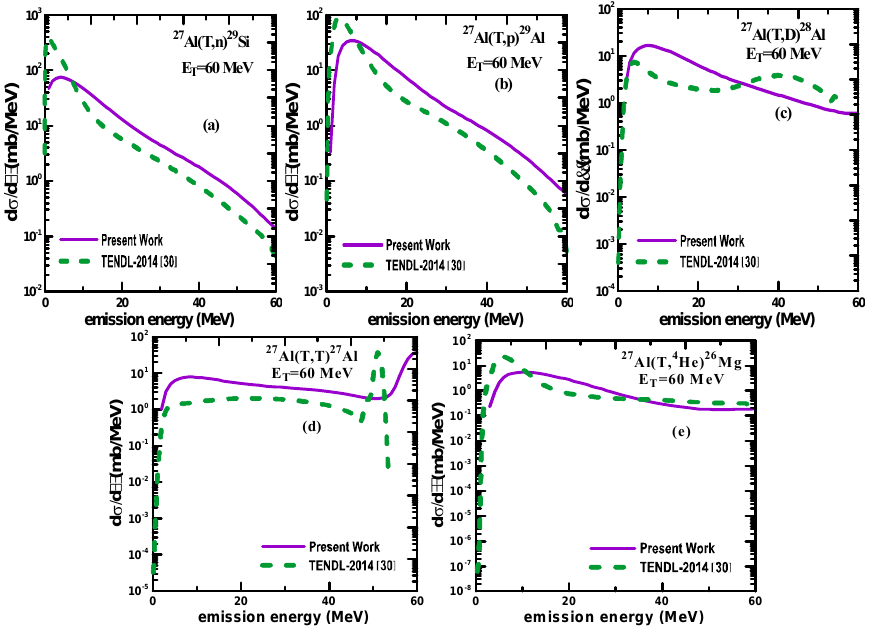
Fig. 5: A comparison between the calculated energy spectrum with refs [30], as a function of particle emission energy in cm-system at 60 MeV incident proton for the reactions, (a) 27 Al (T, n) 29 Si (b) 27 Al (T, p) 29 Al (c) 27 Al (T, D) 28 Al (d) 27 Al (T, T) 27 Al (e) 27 Al (T, 3 He) 27 Mg (f) 27 Al (T, 4 He) 26